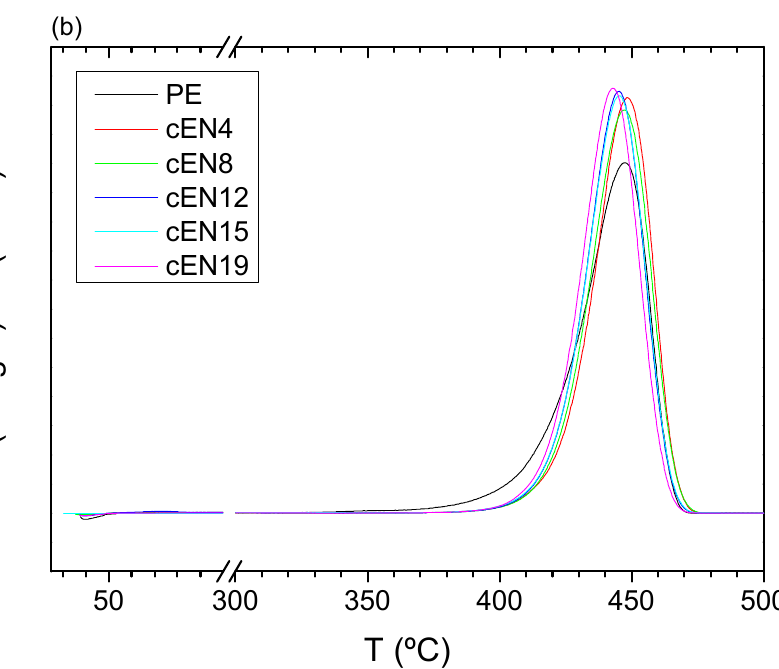
Figure 9. TGA curves ( a ) and DGTA curves ( b ) for all the samples under inert conditions.